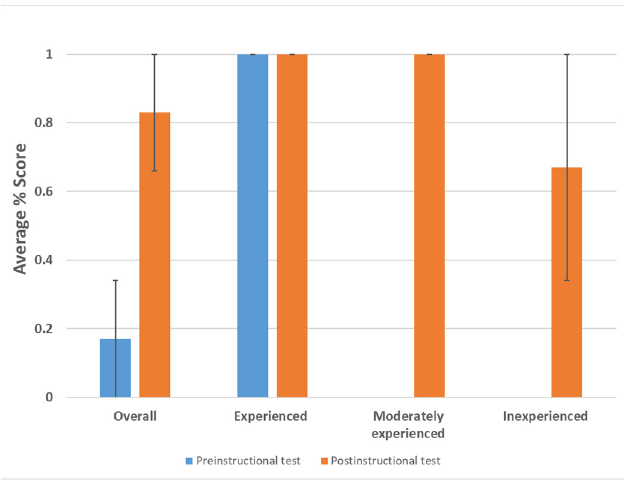
Figure 5. Pre-instructional and post-instructional test results.